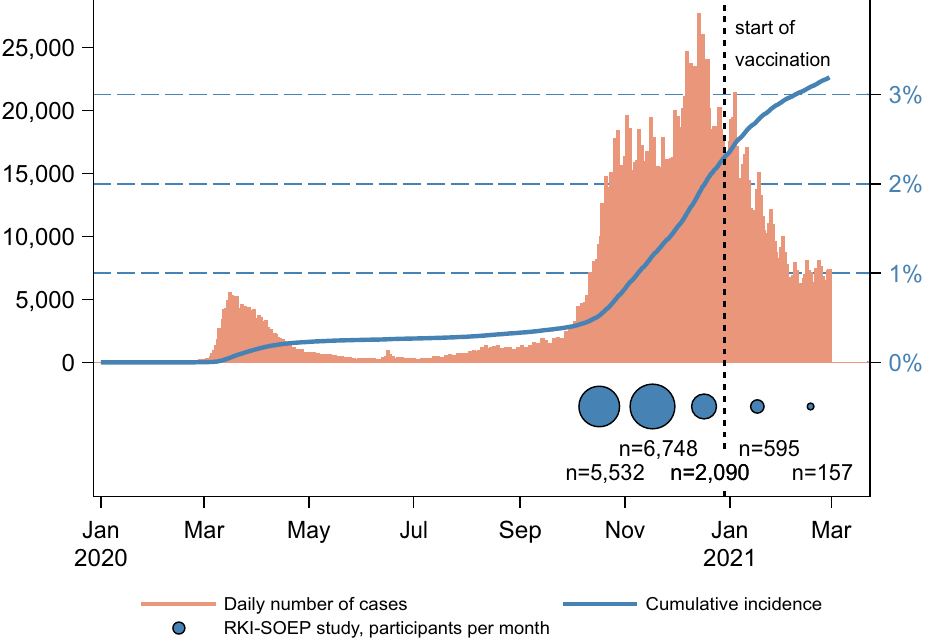
Figure 1. Notified COVID-19 cases (based on positive PCR tests) in adults 18 years or older in Germany (top panel) and sampling distribution of the RKI-SOEP study (bottom panel). Dashed vertical line: start of vaccination